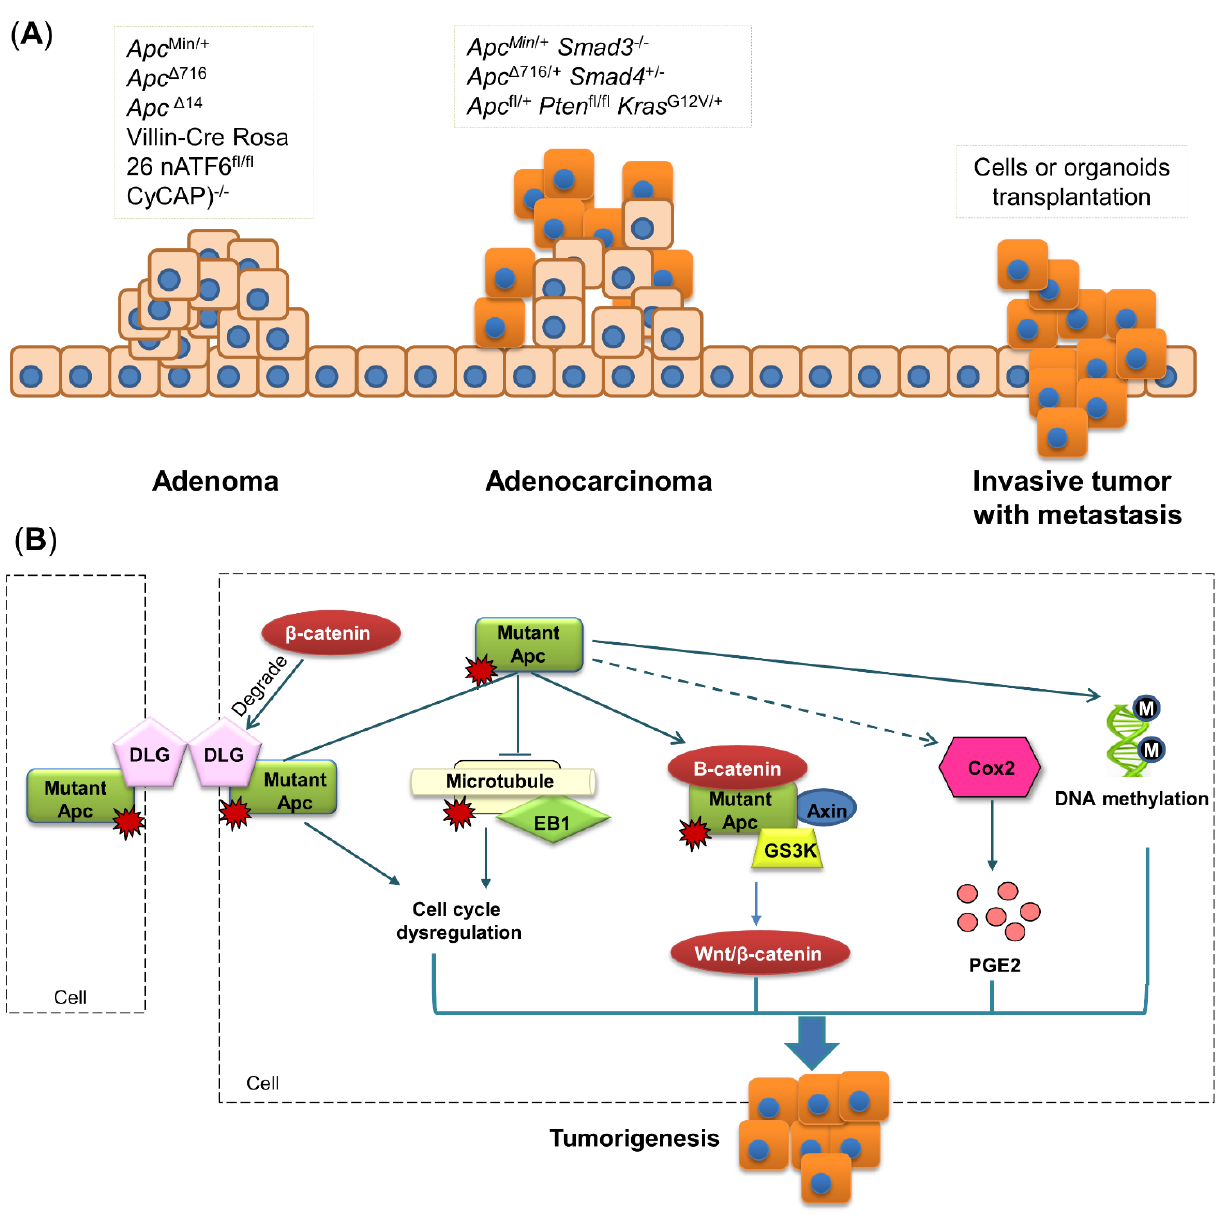
Figure 3. Transgenic mouse models. ( A ) Schematic of gene mutation in each stage of colon tumorigenesis. Single gene mutation mostly induces the development of adenomas, while multiple gene mutations can promote the formation of adenocarcinomas. Metastasis is rarely observed in transgenic mouse models, and its appearance in mice requires transplantation of cancer cells or organoids. ( B ) Apc mutation results in the activation of a destruction complex consisting of β -catenin, Apc , Axin and GS3K. The EB1-microtubule complex and DLG are destructed by mutant Apc , causing cell-cycle dysregulation. Apc mutation also promotes DNA methylation and Cox2 activation. All these alterations induced by Apc mutation can lead to colon tumorigenesis. Apc , adeno A recent study matous polyposis coli; Cox2, cyclooxygenase 2; CyCAP, cyclophilin C-associated protein; DLG, discs-large; EB1, end-binding protein 1; GSK3, glycogen synthase kinase 3; Kras , Kirsten rat sarcoma viral oncogene homolog; nATF6, activating transcription factor 6; PGE2, prostaglandin E2; PTEN, phosphatase and tensin homolog; Wnt, wingless-related integration site.